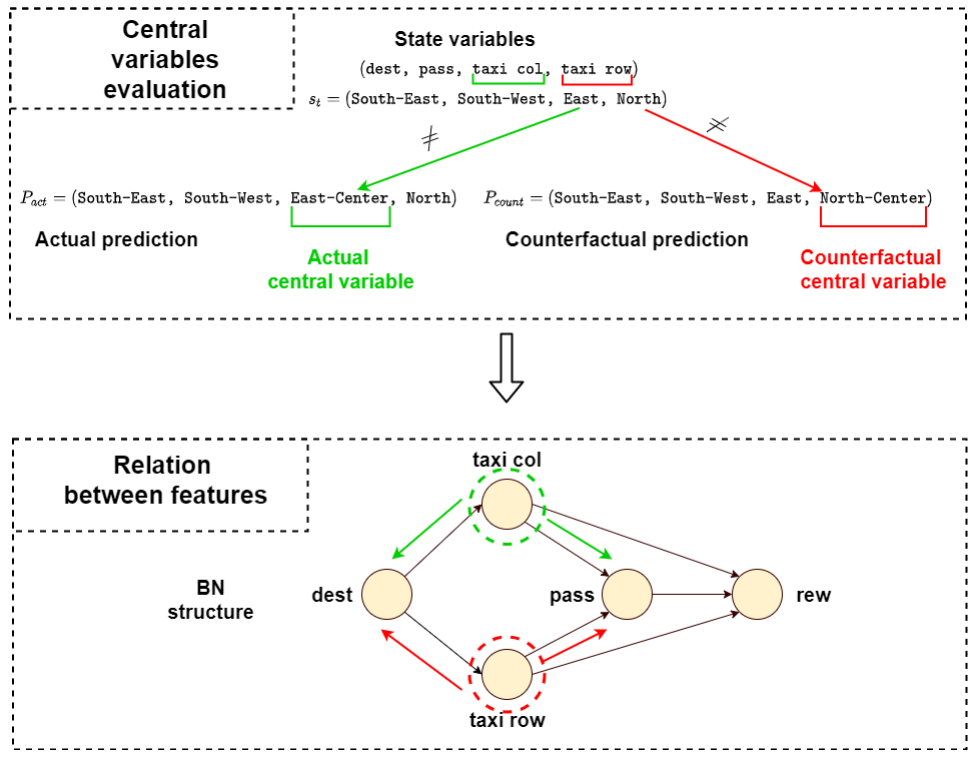
Figure 9. Evaluation of the central variables and estimation of the actual (green) and counterfactual (red) chains for the determination of the feature relations used in the